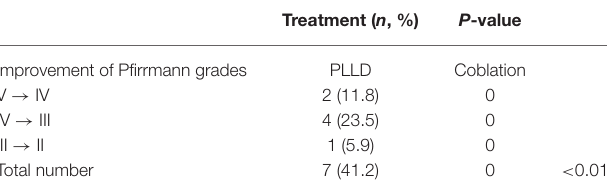
TABLE 4 | Comparison between pre- and postoperative disc degeneration.